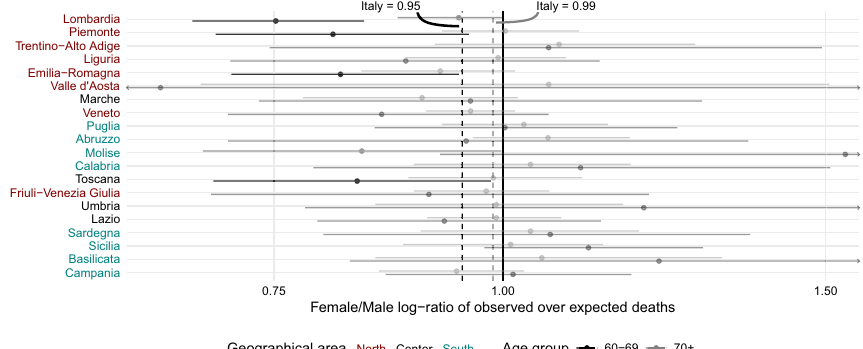
Fig. 2 Female/male ratio of observed over expected deaths on log scale by 20 Italian regions for the age groups 60–69 and